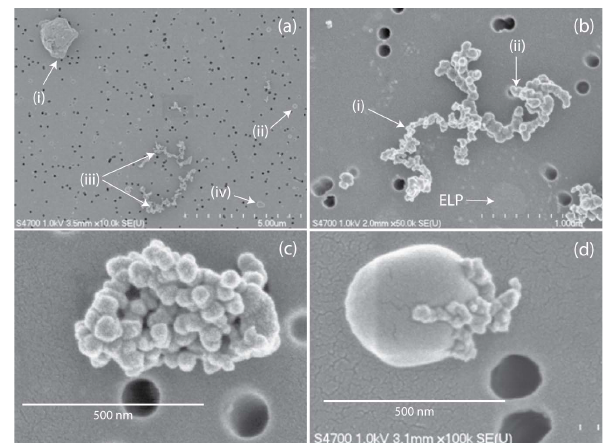
Fig. 16. FE-SEM images of aerosol particles collected at the T0 site: (a) a low magnification image showing (i) dust particle, (ii) spherical particle, (iii) fractal-like particles, (iv) irregularly-shaped particle; (b) fractal-like particle with open structure, (i) soot without evident coating, (ii) soot with relatively thick coating, ELP – evap- orated liquid particle; (c) compacted BC particle internally mixed; (d) particle with BC inclusion. The dark dots are the pores in the